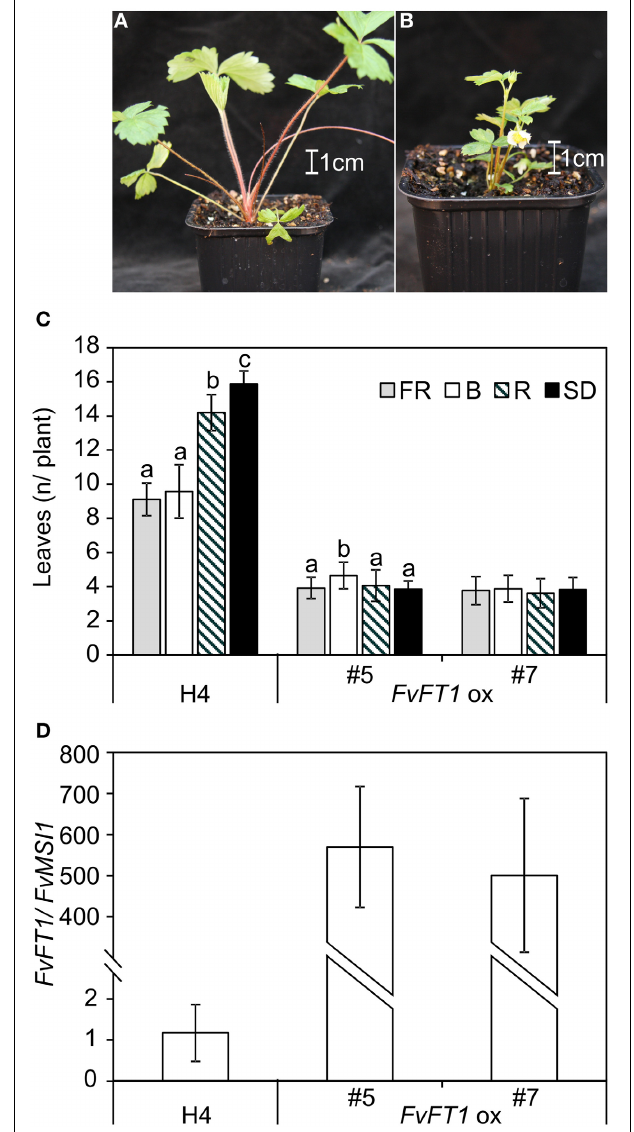
FIGURE 2 | The overexpression of FvFT1 causes extreme early flowering in the perpetual flowering F. vesca accession Hawaii-4 (H4). (A) H4 wild type, and (B) 35S:FvFT1 line #7 at the age of 8 weeks. (C) Flowering time of FvFT1 overexpression lines in different end-of-day light quality treatments indicated as the number of leaves in the primary leaf rosette before the terminal inflorescence (#5: n = 21–31, #7: n = 13–18, wild type H4: n = 36–38). Flowering results were subjected to Two-Way ANOVA ( p < 0 . 001 for each of treatment, genotype, and treatment × genotype interaction). Pairwise comparisons were carried out for every genotype separately using Tukey’s test, α = 0 . 01. Treatments with different letters indicate significant differences within the genotype. (D) The expression of FvFT1 in 35S:FvFT1 plants compared to wild type Hawaii-4 under LD (18h). T 1 and H4 seedlings with open cotyledons were subjected to 12-h short-day (SD) or 12-h SD plus 6-h low intensity (15 μ mol m − 2 s − 1 ) end-of-day treatment with far-red, red or blue light (FR, R, and B, respectively) at 22 ◦ C for 8 weeks. For gene expression data, three biological replicates were analyzed by real-time PCR. Leaf samples were collected 16h after dawn. All results are mean ± SD